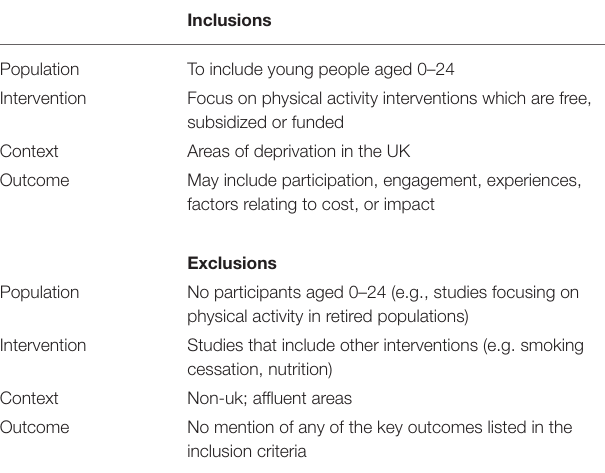
TABLE 1 | Criteria for including studies in the